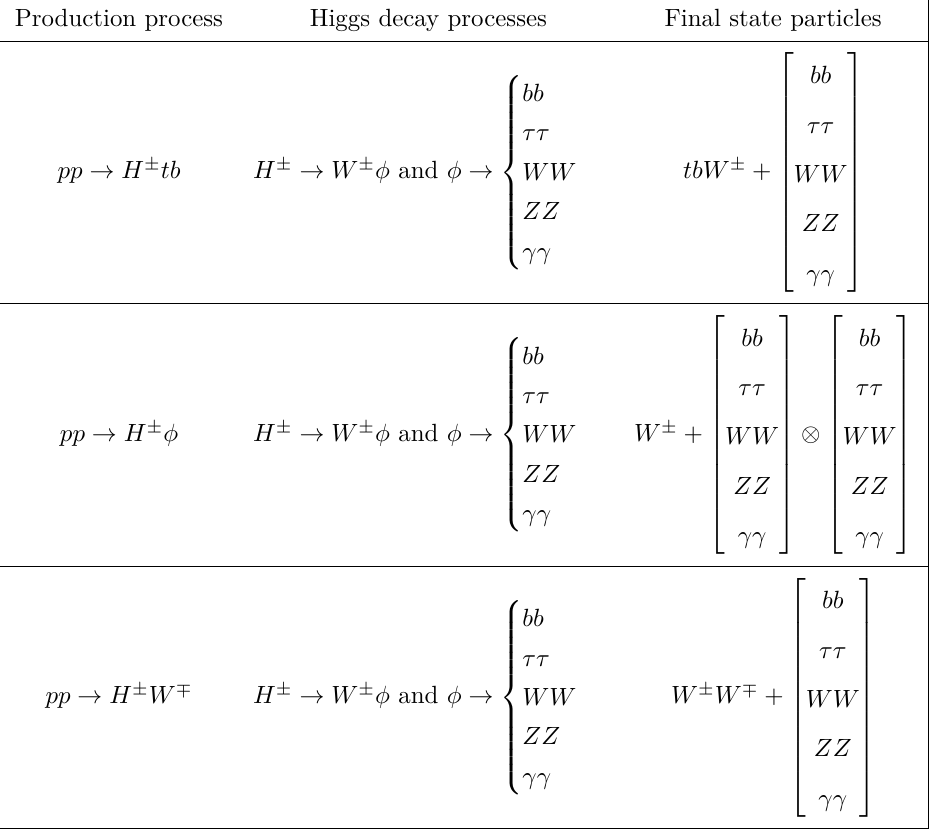
Table 4. LHC signatures arising from the charged Higgs boson decay H ± → W ± φ , with a neutral non-SM-like Higgs boson, φ = h , for the most relevant production ( first column ) and decay BSM , A ( second column ) processes. The resulting final state particles are given in the third column (further decays of the SM particles are not explicitly shown). The “ ⊗ ” symbol in the center right cell indicates that any combination of the final states within the square brackets can occur due to the independent decays of the two neutral Higgs